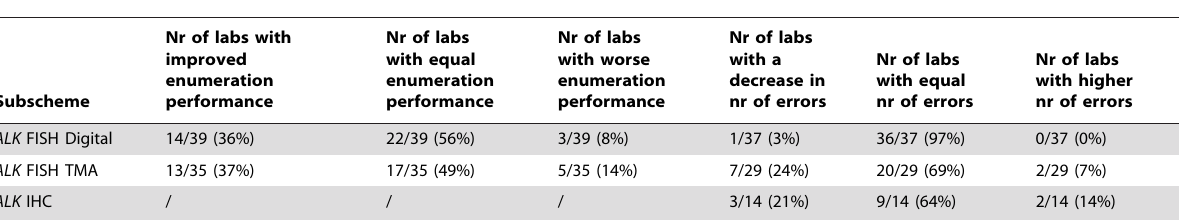
Table 3. Performance of laboratories that participated in both